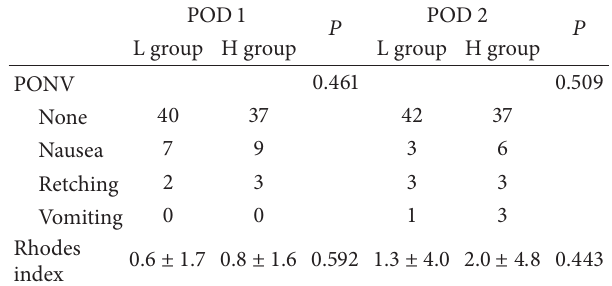
Table 4: Postoperative nausea and vomiting (PONV). POD 1